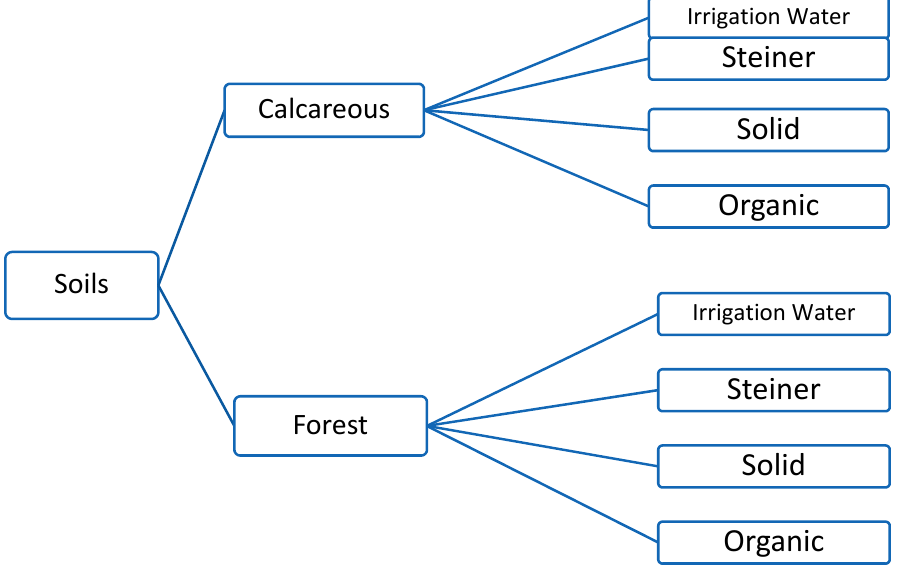
Figure 1. Diagram for the different nutritional contributions of each type of soil.